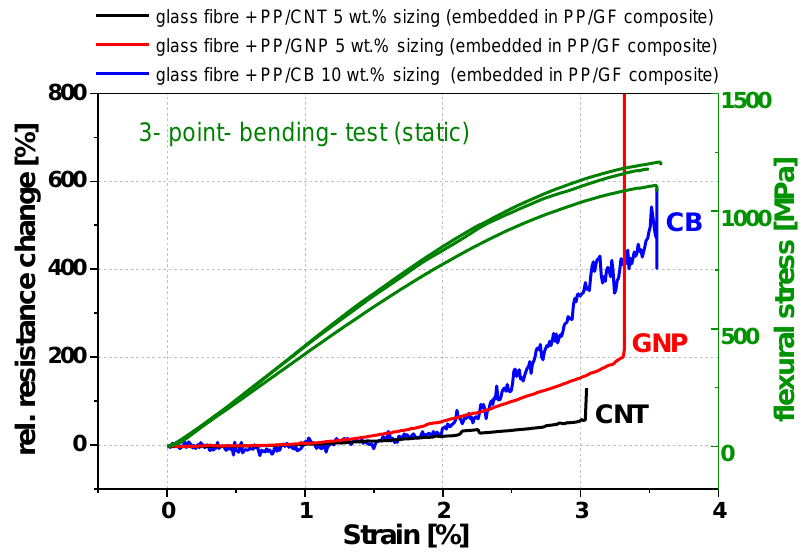
Figure 7. Electro-mechanical response behaviour of in-line nanostructured sensor fibre using 5 wt.% CNT embedded in the neutral plane zone, during a static 3-point bending test (span to length L/h ratio of 33). Table 2. Sensitivity values (gauge factor) of in-line nanostructured fibres in a linear range (up to 1% strain) of nanostructured sensor fibres using different carbon filler (CNT, GNP, CB) embedded in the neutral plane zone during a quasi-static 3-point bending test; the gauge factor is the ratio of relative change in electrical surface resistance (∆R/R ) to the mechanical strain (∆l/l ). Sample Gauge Factor (Neutral Plane Zone)